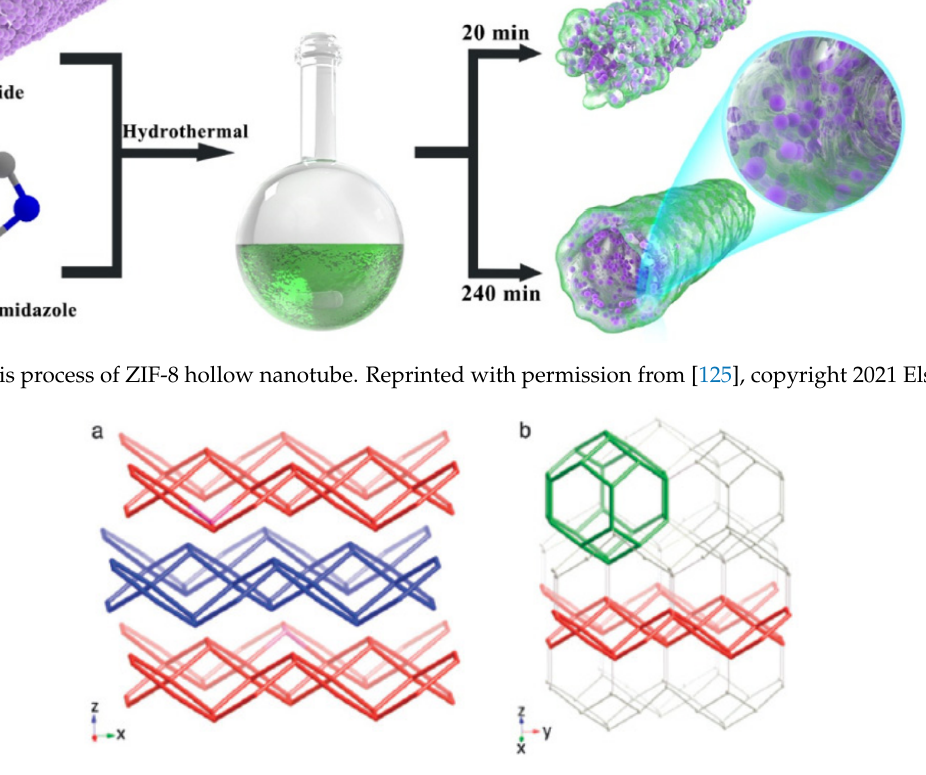
Figure 7. Synthesis process of ZIF-8 hollow nanotube. Reprinted with permission from [125], copyright 2021 Elsevier.